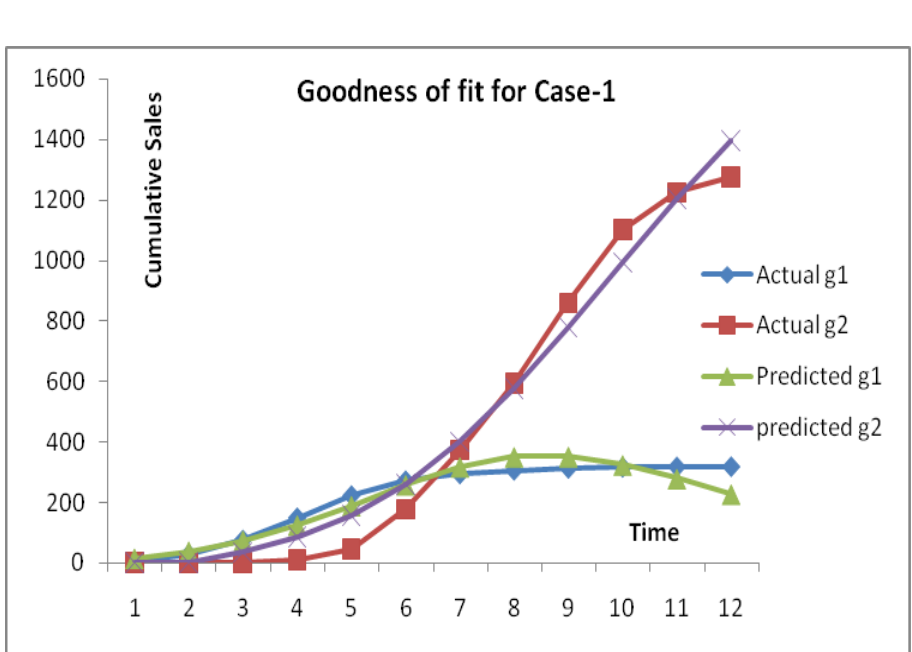
Fig. 1. Goodness of fit curve for